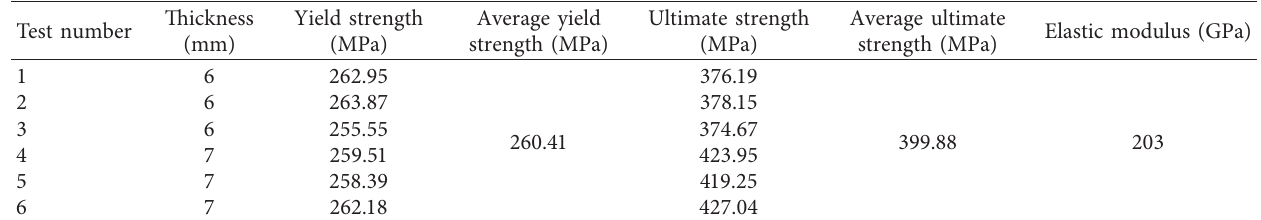
Table 3: Elastic modulus of hot-rolled H steel.